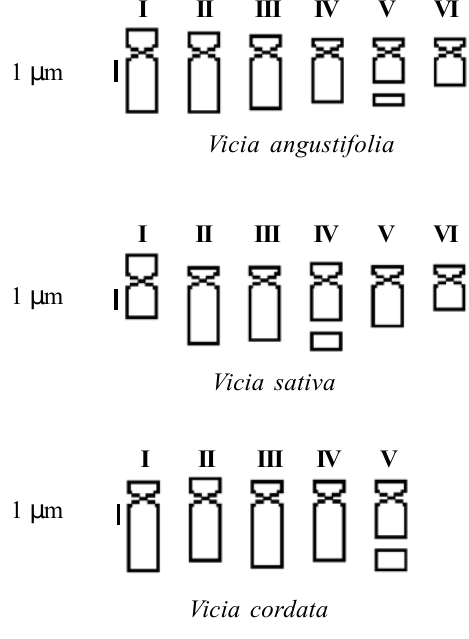
Figure 2 - Idiograms of the Vicia sativa aggregate taxa (from Weber and Schifino-Wittmann,